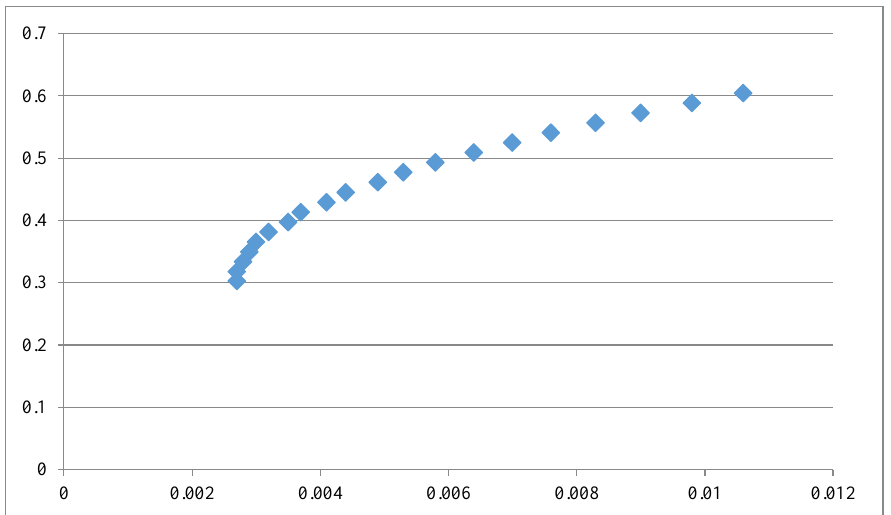
Figure 2. Efficient frontier based on data of Table 1.